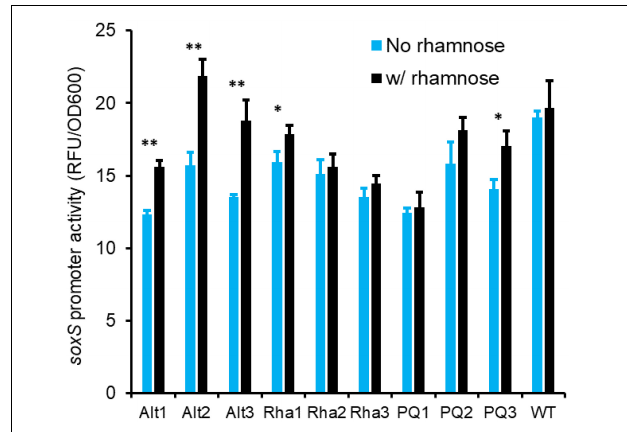
FIGURE 6 | Lines evolved with alternating exposure to rhamnose and paraquat (Alt1, Alt2, and Alt3) exhibit a higher expression from the soxS promoter after growth for 8 h in the presence of rhamnose. This rhamnose-dependent activation of the soxS promoter is absent in the ancestor (WT), in rhamnose-evolved lines (Rha1, Rha2, and Rha3), and in paraquat-evolved lines (PQ1, PQ2, and PQ3) ( ∗∗ indicates p -value < 0.002, ∗ indicates p -value < 0.02, two-tailed, paired t